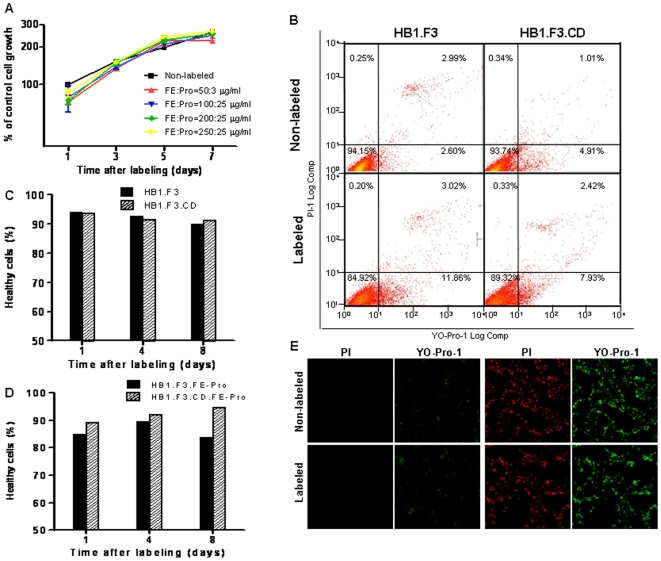
Cellular viability of FE-Pro-labeled NSCs.(A) Cellular biomass normalized to non-labeled NSC cell growth at day 1 as measured by absorbance of protein-bound sulforhodamine B (SRB) at 570 nm. Data are mean±SE of triplicate samples and were analyzed using paired t-test between non-labeled vs. each FE-Pro dosage. P<0.05 was considered statistically significant. (B) Representative FACS plots showing the viable and apoptotic cell populations at 24 hours post-label and before sub-culturing. (C–D) Bar graphs showing the percentage of healthy cells at days 1, 4 and 8 for non-labeled NSCs (C), and FE-Pro-labeled NSCs (D) after sub-culturing passage at each time point. (E): Confocal images of healthy FE-Pro labeled and non-labeled NSCs (left panel) and apoptosis-induced FE-Pro labeled and non-labeled NSCs (right panel) at Day 6 post-labeling. Staining: PI (red), YO-Pro-1 (green). A FE-Pro dosage of 50∶3 µg/ml was used for each labeled sample unless otherwise indicated. Abbreviations: FE-Pro, Ferumoxide-Protamine Sulfate complex; PI, propidium iodide; Magnification: 20×.